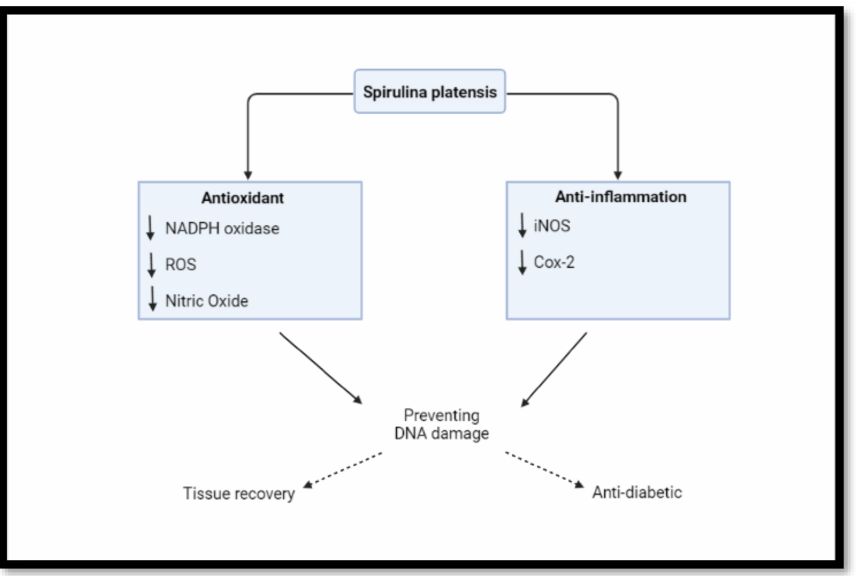
Figure 3. Antioxidant and anti-inflammatory effects of SP (created with BioRender.com, accessed on 17 November